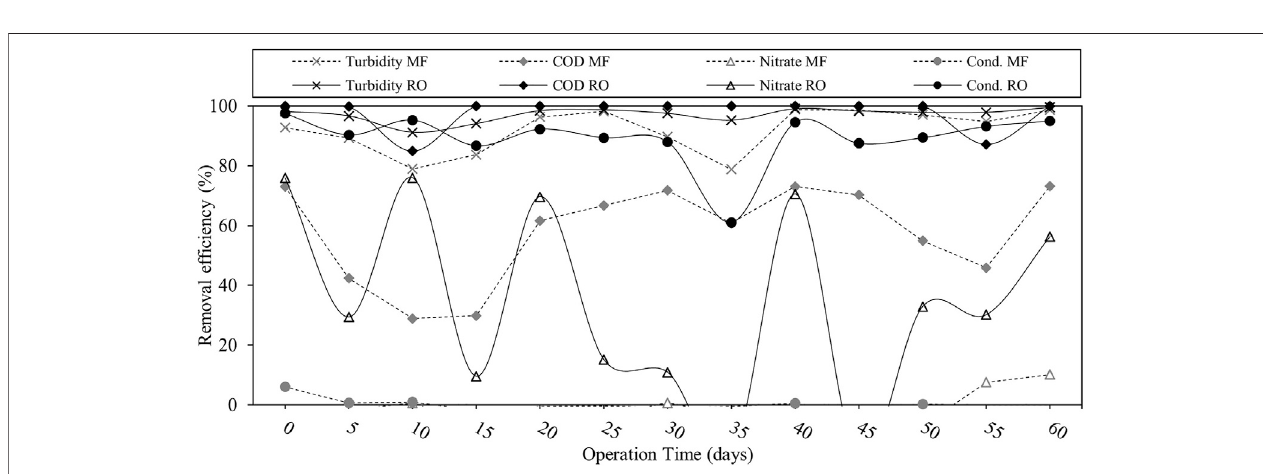
FIGURE 6 | Time-course of removal ef fi ciency for turbidity, organic matter, nitrate and conductivity obtained by the MF and RO membranes in the ozone- coagulation-MF-RO treatment system.